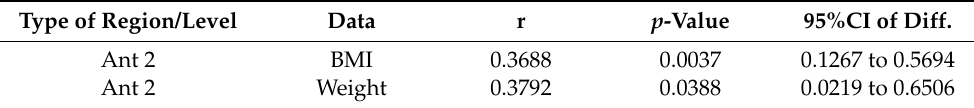
Table 7. Correlations (Pearson R coefficient test) between the superficial fascia of the arm: Ultrasound measurements and descriptive data. Only statistically significant data are reported. BMI = body mass index.